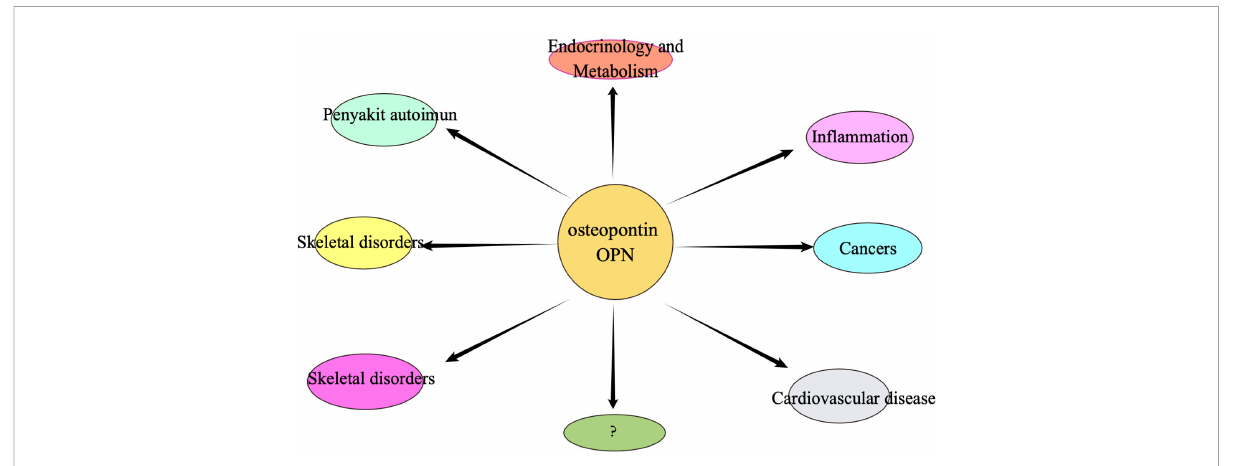
FIGURE 3 Osteopontin may be associated with many of the different types of diseases mentioned